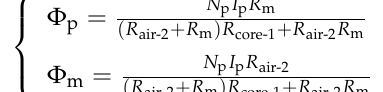
Figure 13. Magnetic circuit model of the proposed magnetic coupler. The parameters of the left and right half of the coil are symmetrical, and only the parameters of the left half are discussed. F 1 is the magnetomotive force aroused by winding, R air is the magnetic resistance of air, R core-1 is the magnetic resistance of ferrites, R core-2 is the magnetic resistance of the nanocrystalline cores, and R m is the sum of the magnetic resistance of mutual inductance flux branch. Φ p is the magnetic flux of self-inductance, Φ m-1 is the mutual inductance flux of the coupler, and Φ m-2 is the mutual inductance flux between the carbon fiber fuselage and the coupler.